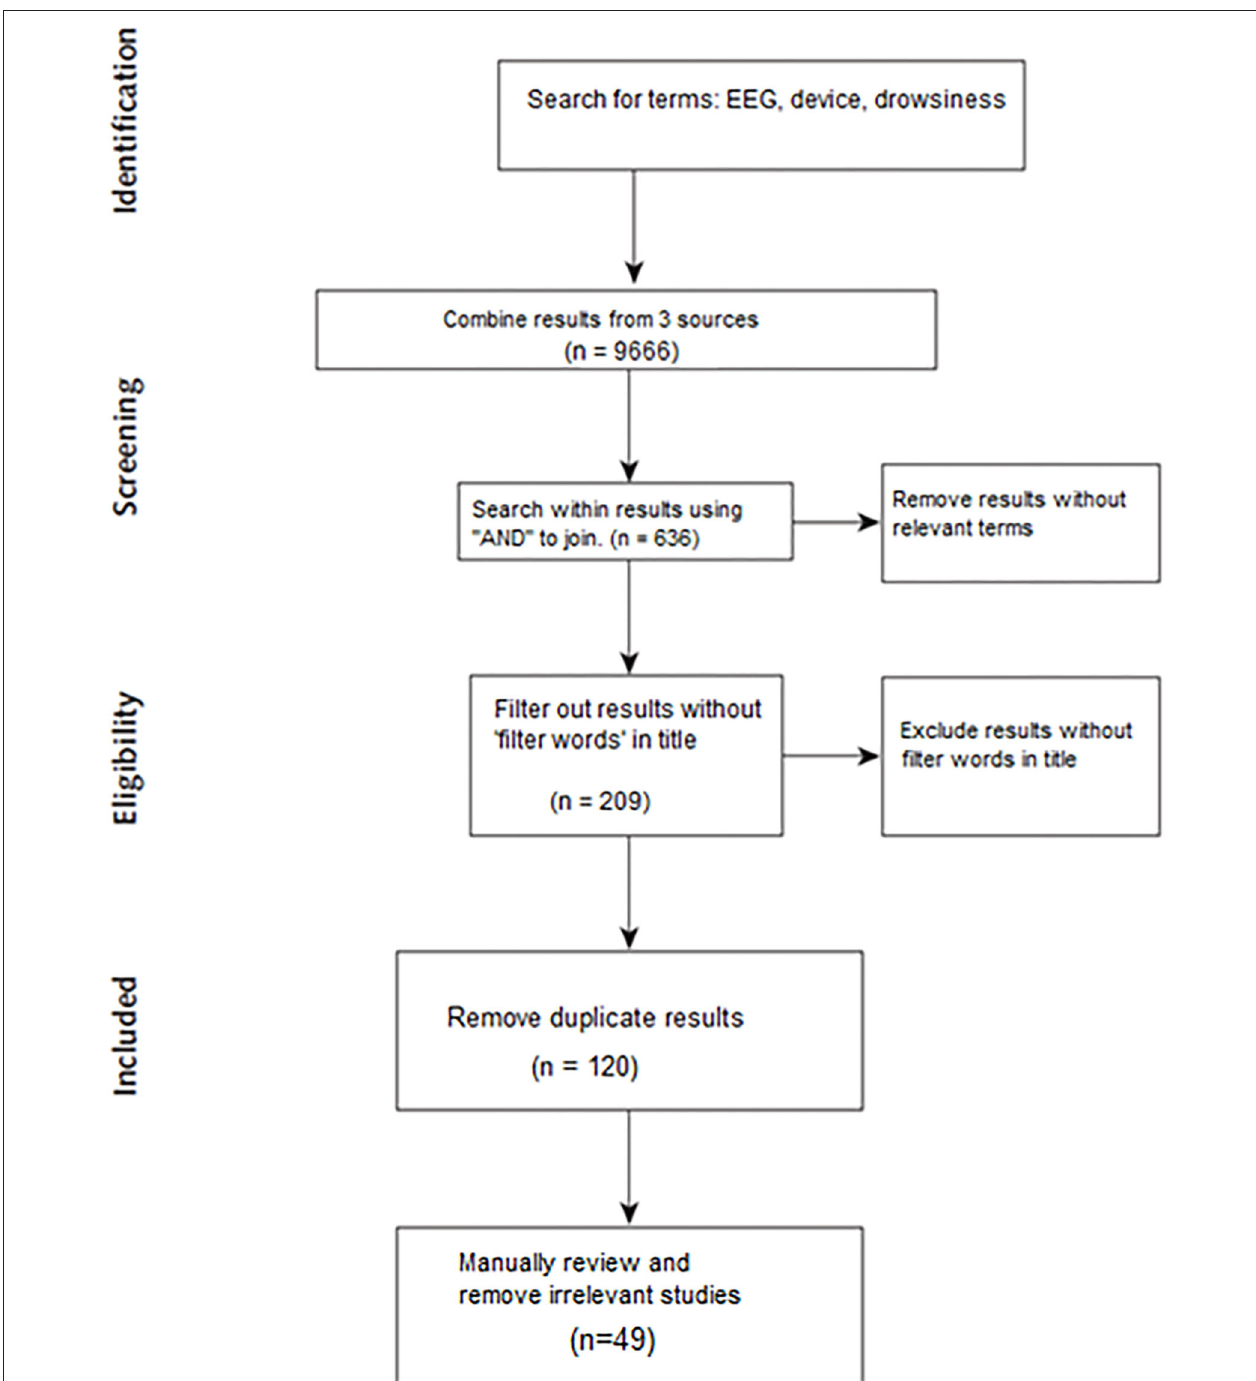
FIGURE 1 | Review search process and